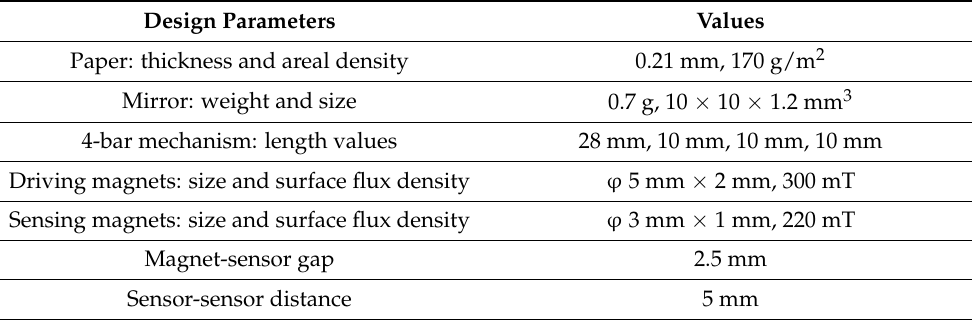
Table 2. Design parameters of the proposed origami laser